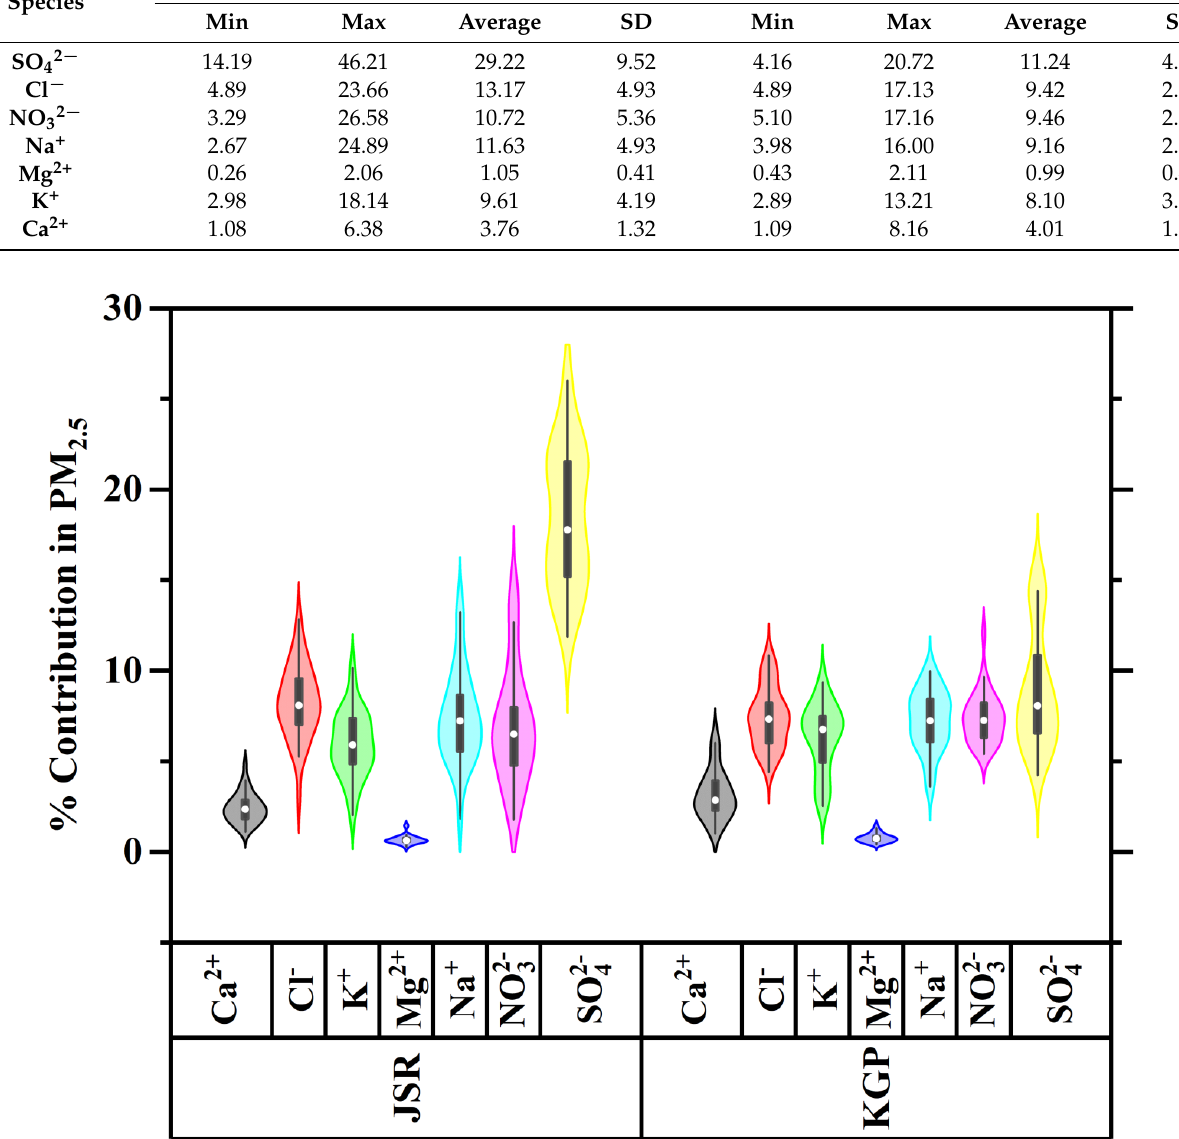
Figure 4. Percentage contributions of major ions in PM 2.5 mass at JSR and KGP sites . Table 3. Statistical analysis of major ionic species concentration (µg/m 3 ) in PM 2.5.